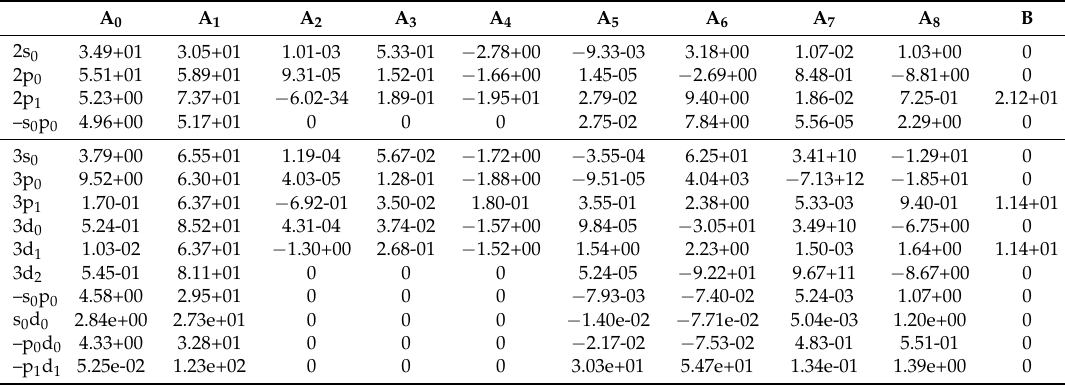
Table 1. Table of fit coefficients for the excitation cross sections and the real part of coherence terms for excitation to n = 2 and n = 3. Expression (12) is applied to fit the atomic orbital close coupling (AOCC) data for all elements except the 2p 1 , 3p 1 , and 3d 1 cross sections in which case the expression (13) must be used. We note that the real part of all coherence terms is negative except for s 0 d 0 excitation. A